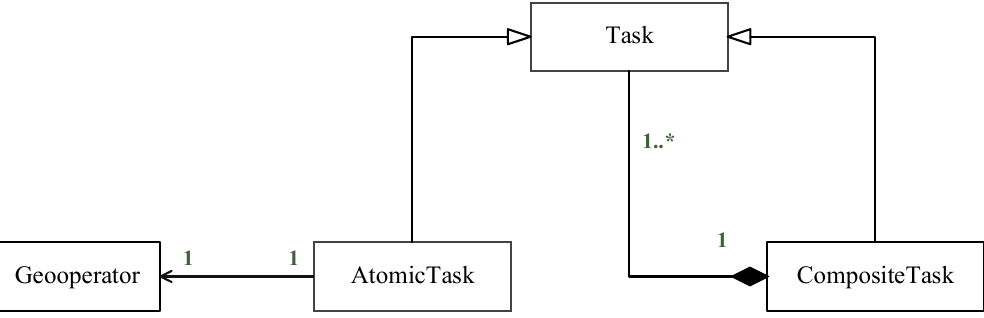
Figure 2. Relationships between Task, AtomicTask, CompositeTask, and Geooperator.